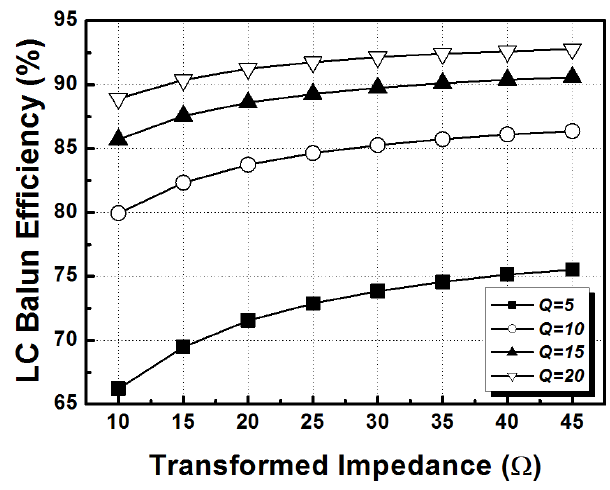
Figure 14. Efficiency of an LC balun (differential-in and single-out).